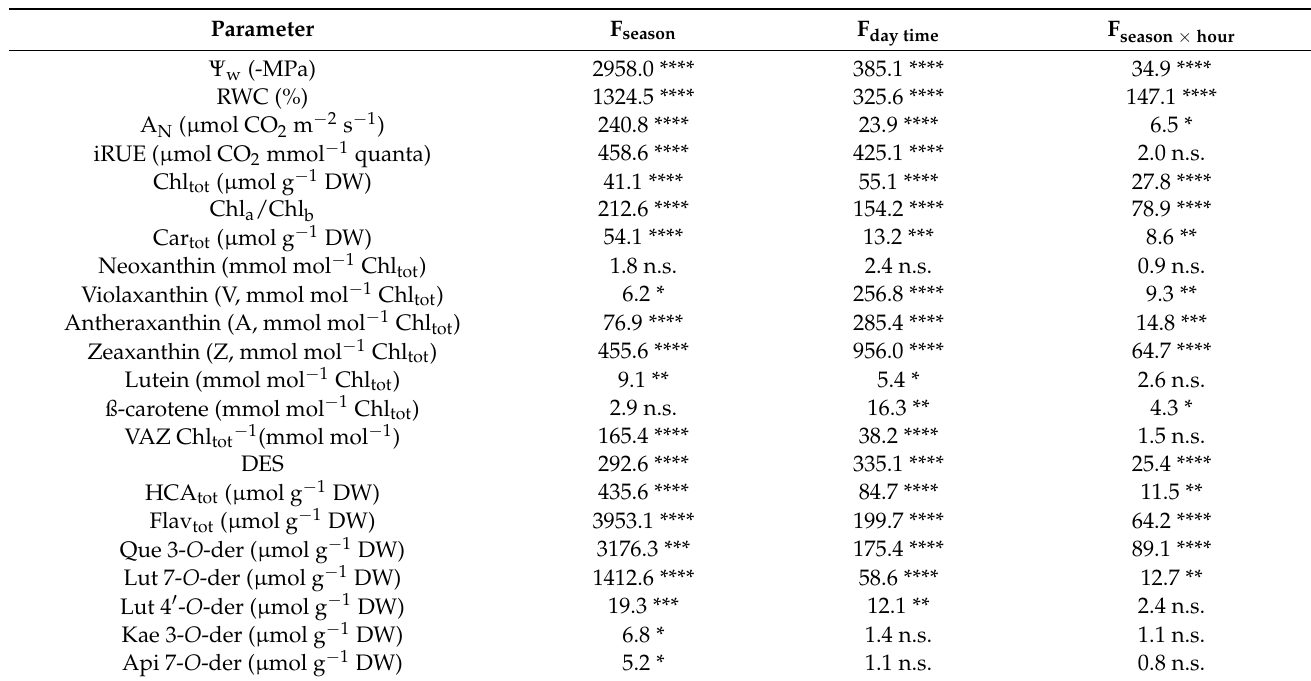
Table 1. Summary of the two-way analysis of variance (ANOVA; season and time of day as fixed factors, with their interaction factors) for the set of physiological (total degrees of freedom = 63) and biochemical (total degrees of freedom = 47) traits of Phillyrea latifolia leaves. In situ measurements and sampling were conducted in two seasons: spring (11–12 and 25–26 May) and summer (4–5 and 22–23 July) in 2019; at four different times of day (08:00–09:00; 12:00–13:00; 14:30–15:30 and 17:30–18:30 h). Ψ w , leaf water potential; RWC, relative water content; A N, net photosynthesis; iRUE, instantaneous